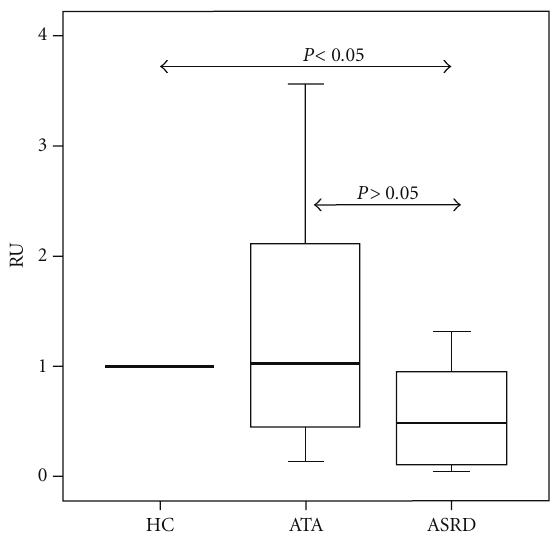
Figure 1: Relative quantification (RU:Relative Units) of galectin- 10 gene expression in PBMC with respect to healthy controls (HC) in patients with aspirin sensitive respiratory disease (ASRD) and aspirin-tolerant asthma